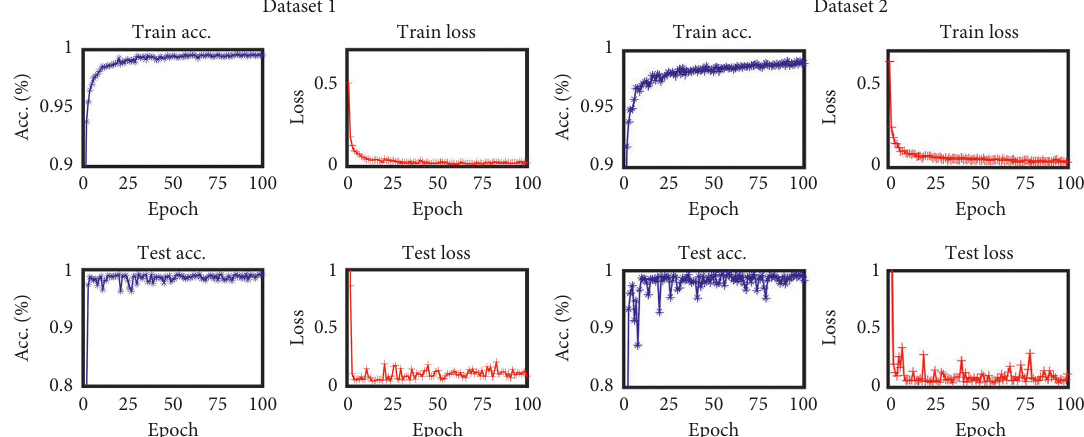
Figure 8: The training process of dataset 1 and dataset 2. A significant convergence trend occurs in both datasets with bigger fluctuations in dataset 2.